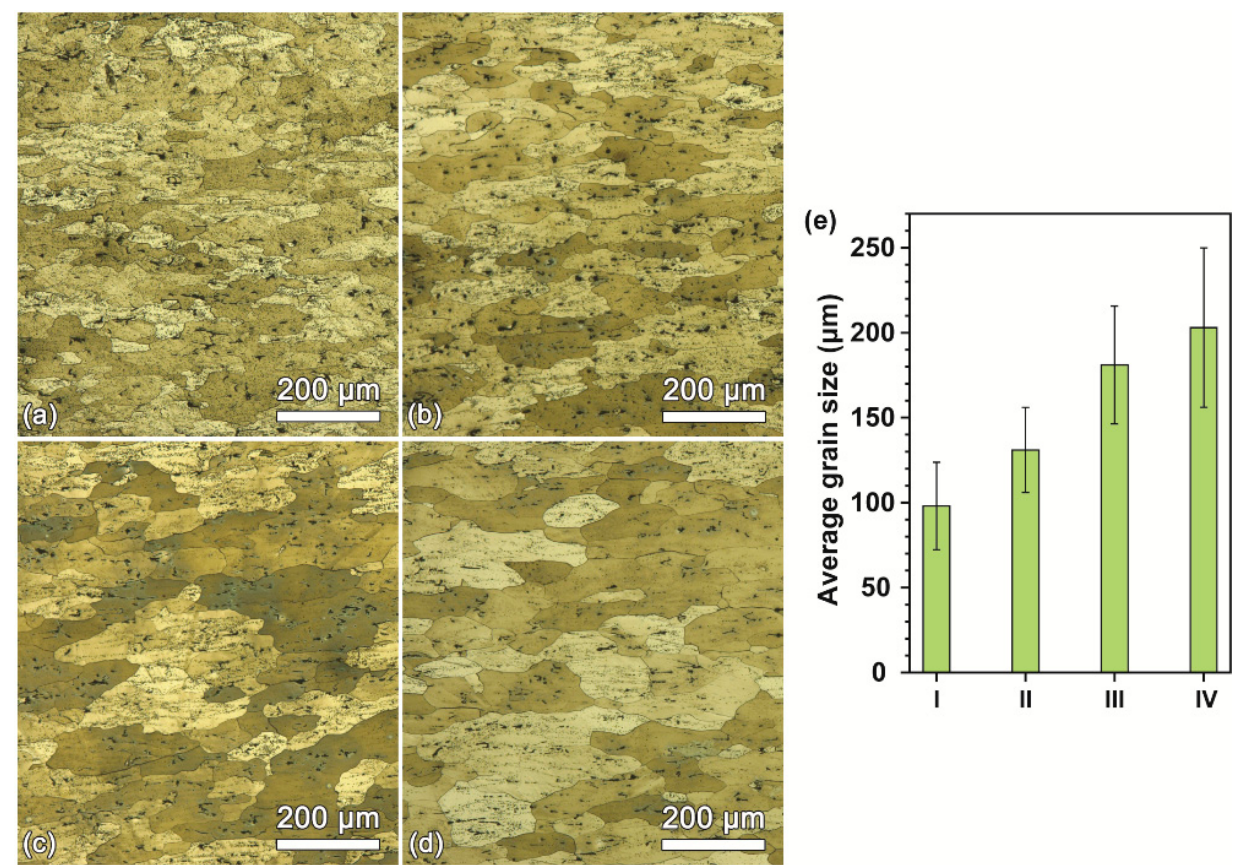
Figure 4. OM microstructures of ( a ) sample I, ( b ) sample II, ( c ) sample III, and ( d ) sample IV. The average grain sizes are provided in ( e ) with the error bar.